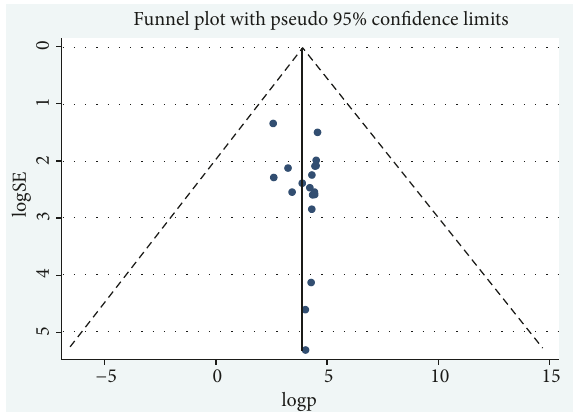
Figure 2: Funnel plot for publication bias, logp, or LNP(log of proportion) represented in the x-axis and standard error of log proportion in the